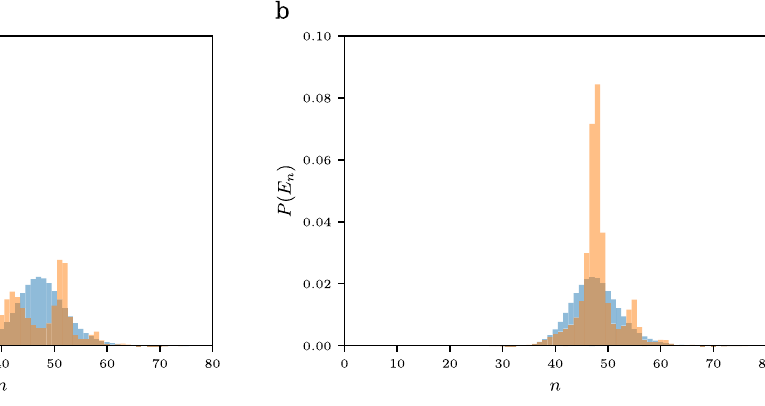
Fig. 6 | Simulation of the initial system state. a Population distribution of negative parity eigenstates of the system when initially prepared in the ∣ (cid:2) 2 _ k momentum state, and the vacuum fi eld mode ( <N >=0), versus the excitation